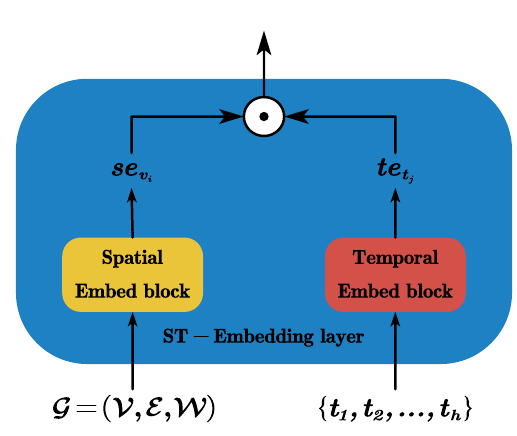
Fig. 2 Structure of ST-Embedding